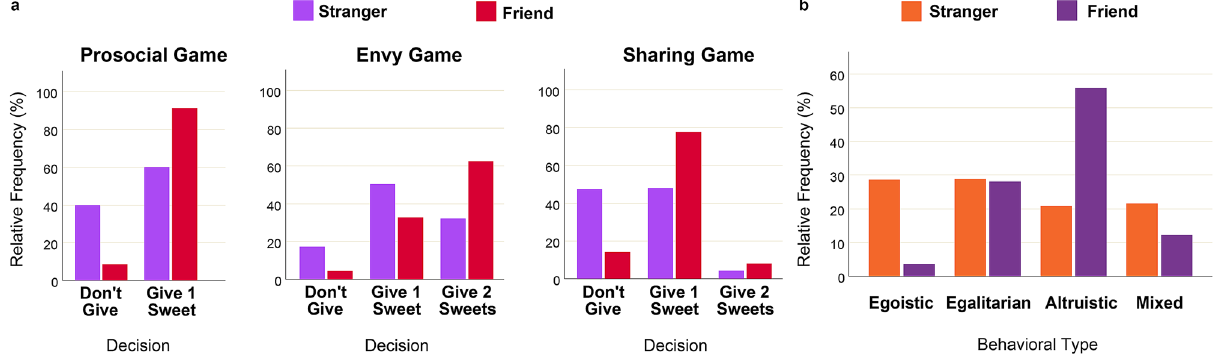
Figure 1. Distributions of individual decisions in the games and distributions of behavioral types towards friends and strangers. ( a ) Differences in distributions of decisions across three games are statistically significant (chi-squared test for independence: X 2 = 4490.71, df = 4, p < 0.001), as well as differences in decisions towards friends and strangers within each game: Prosocial Game (chi-squared test for independence: X 2 = 602.27, df = 1, p < 0.001), Envy Game (X 2 = 485.89, df = 2, p < 0.001), Sharing Game (X 2 = 614.57, df = 2, p < 0.001); ( b ) differences in the distributions of behavioral tendencies (Egoistic, Egalitarian, Altruistic, and Mixed) towards friends and strangers are statistically significant (chi-squared test for independence: X 2 = 923.78, df = 3, p <